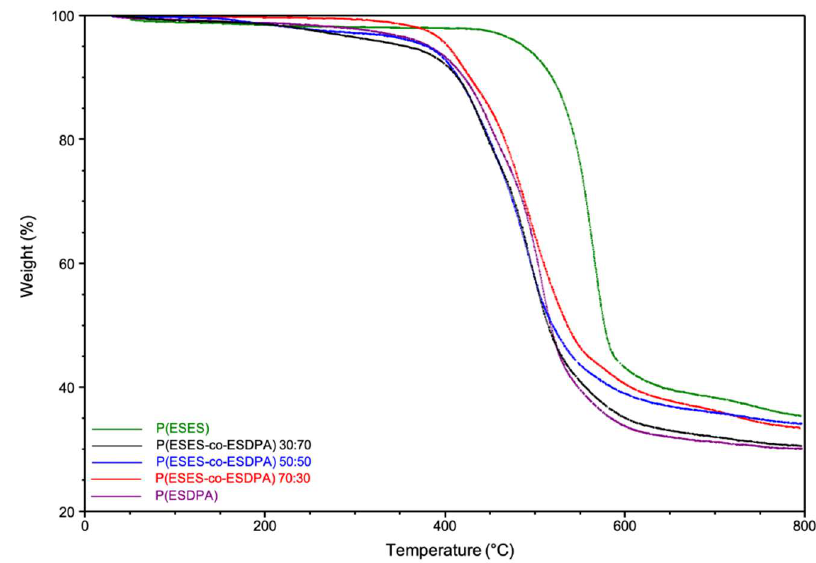
Figure 1. Overlay of thermogravimetric curves of P(ESDPA)-co-(ESES) copolymers and their homopolymers.